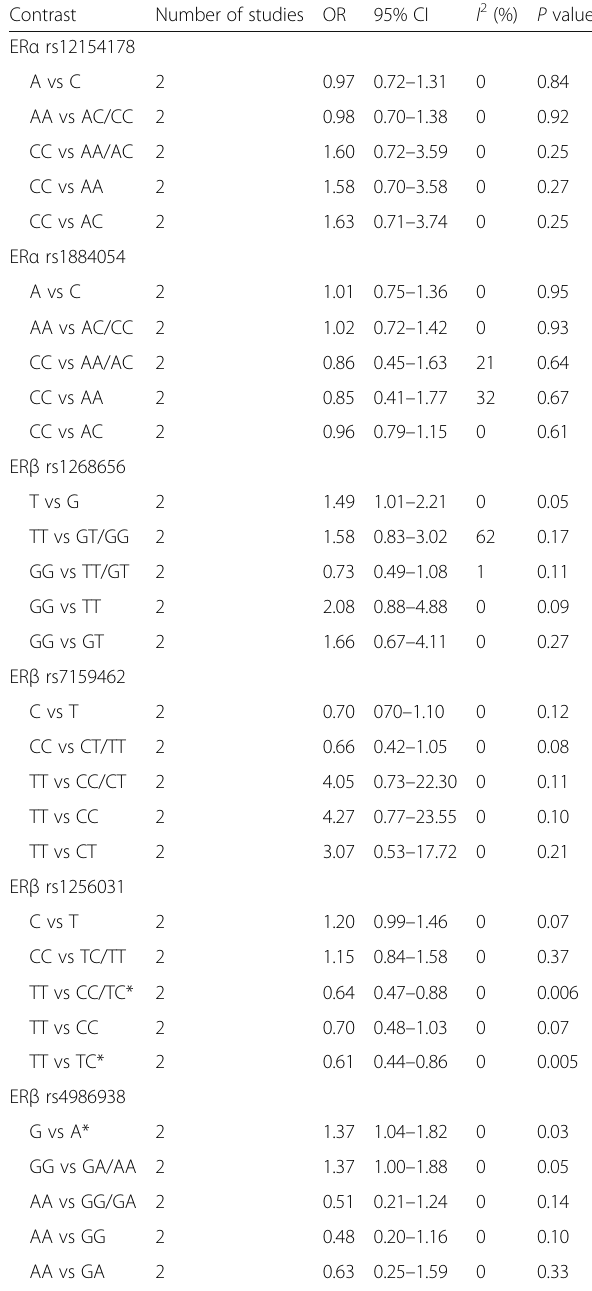
Table 3 Meta-analysis for the association between ER polymorphisms and the risk of OAG